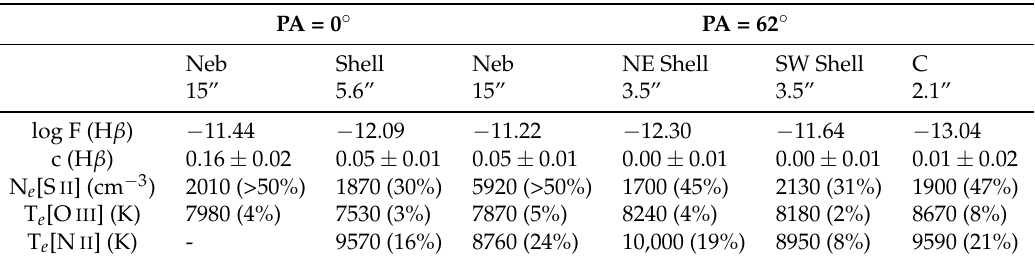
Table 1. Results for position angles 0 ◦ and 62 ◦ . Percentage errors are given within parentheses.